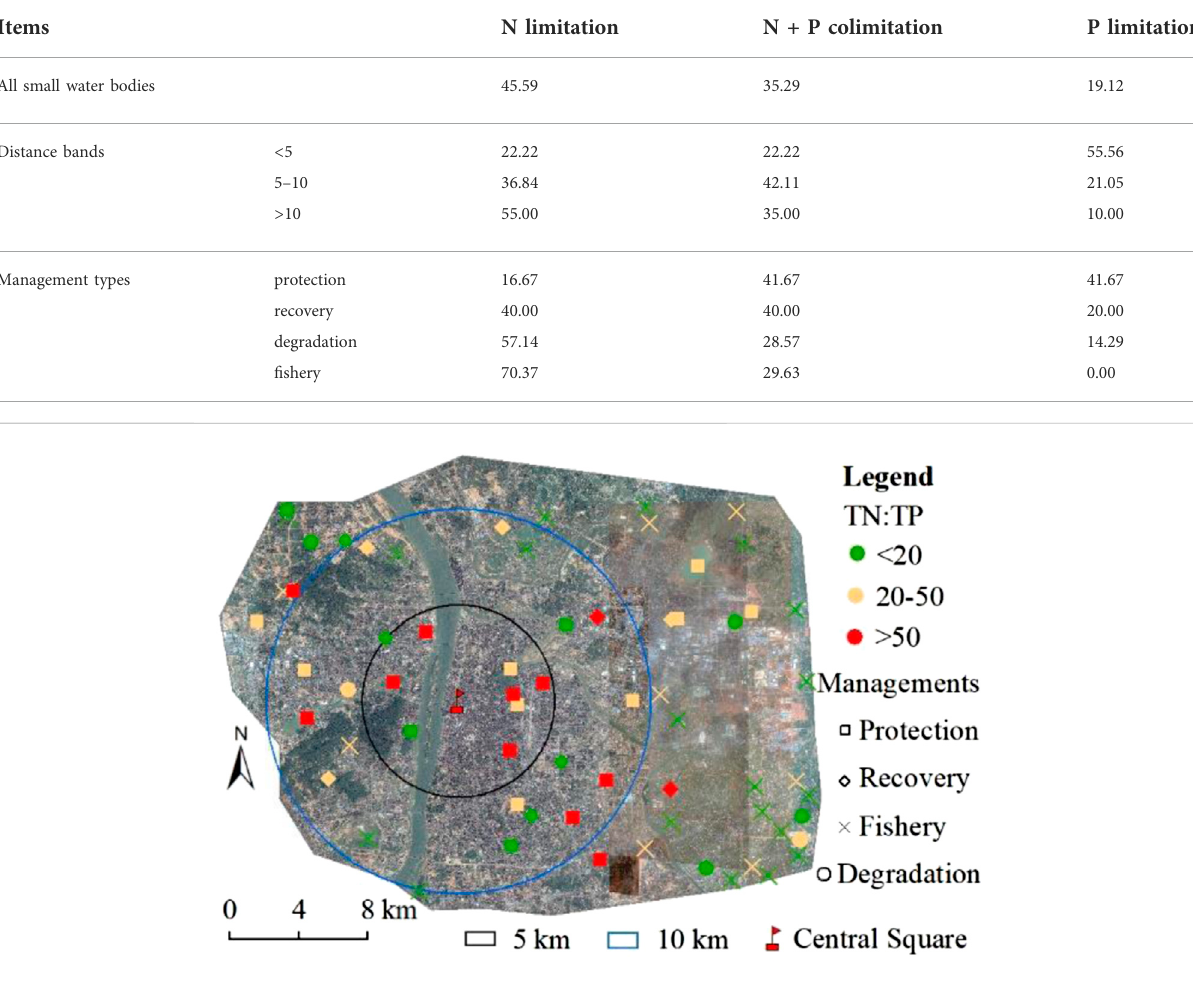
TABLE 2 Comparison of N and P nutrient limitation in small water bodies under different distance bands and management types.